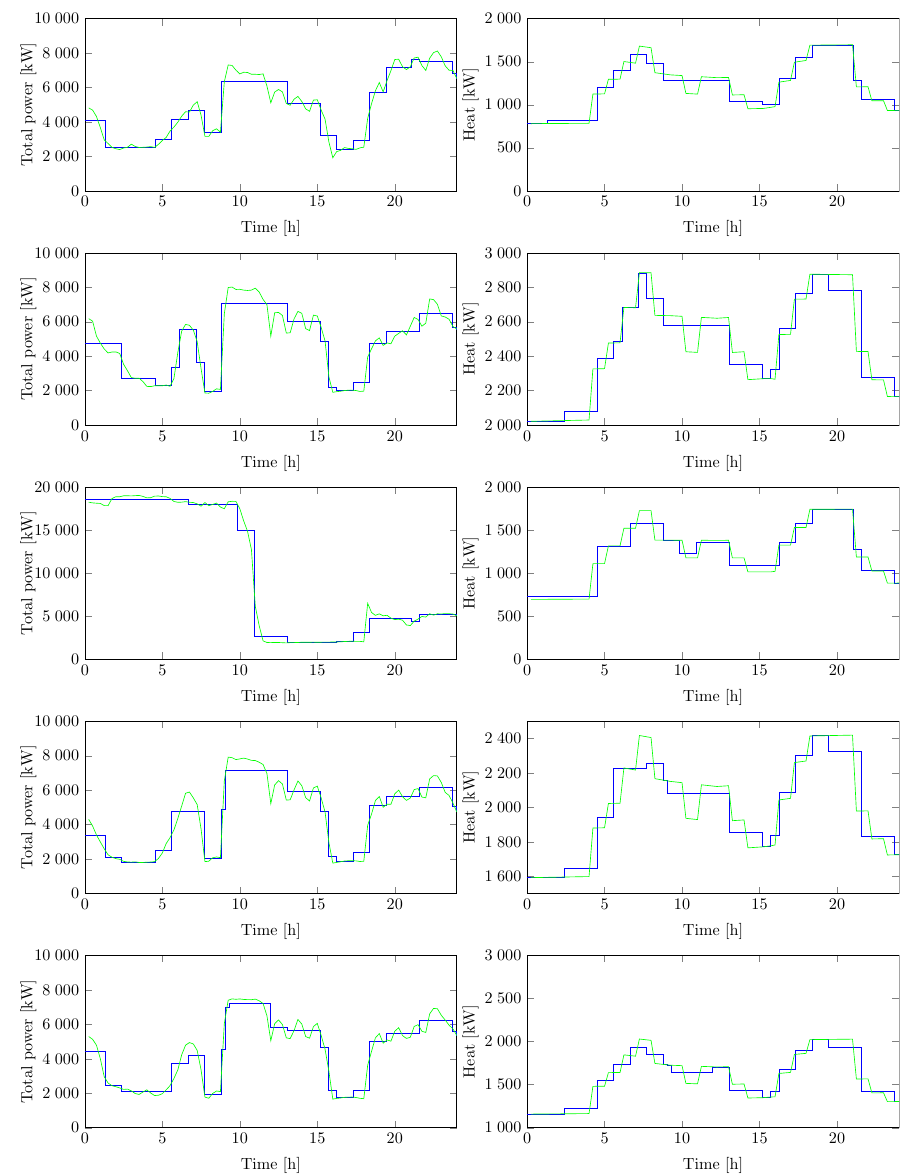
Figure 22. Power ( left ) and heat ( right ) profiles, original (green) and segmented (blue), for the 5 typical days and duration